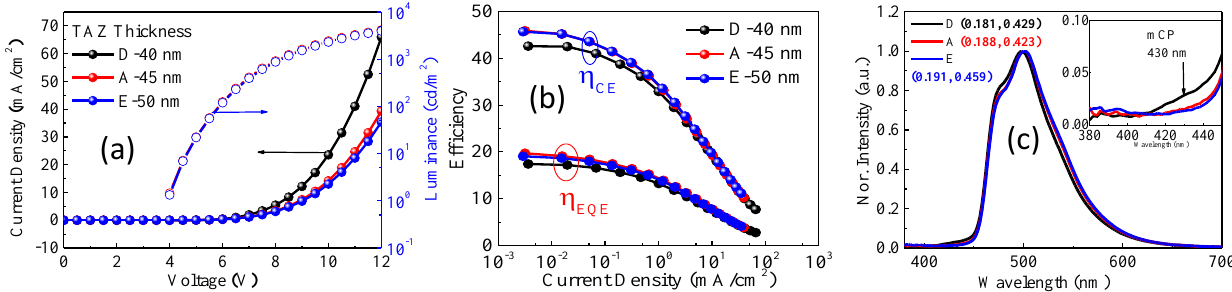
Figure 3. ( a ) L–J–V characteristics ( b ) CE and EQE as a function of current density ( c ) EL spectra and color coordinates measured at driving voltage of 12 V; inset is EL spectra at the wavelength range 380–460 nm, in blue PHOLEDs with various TAZ thickness.